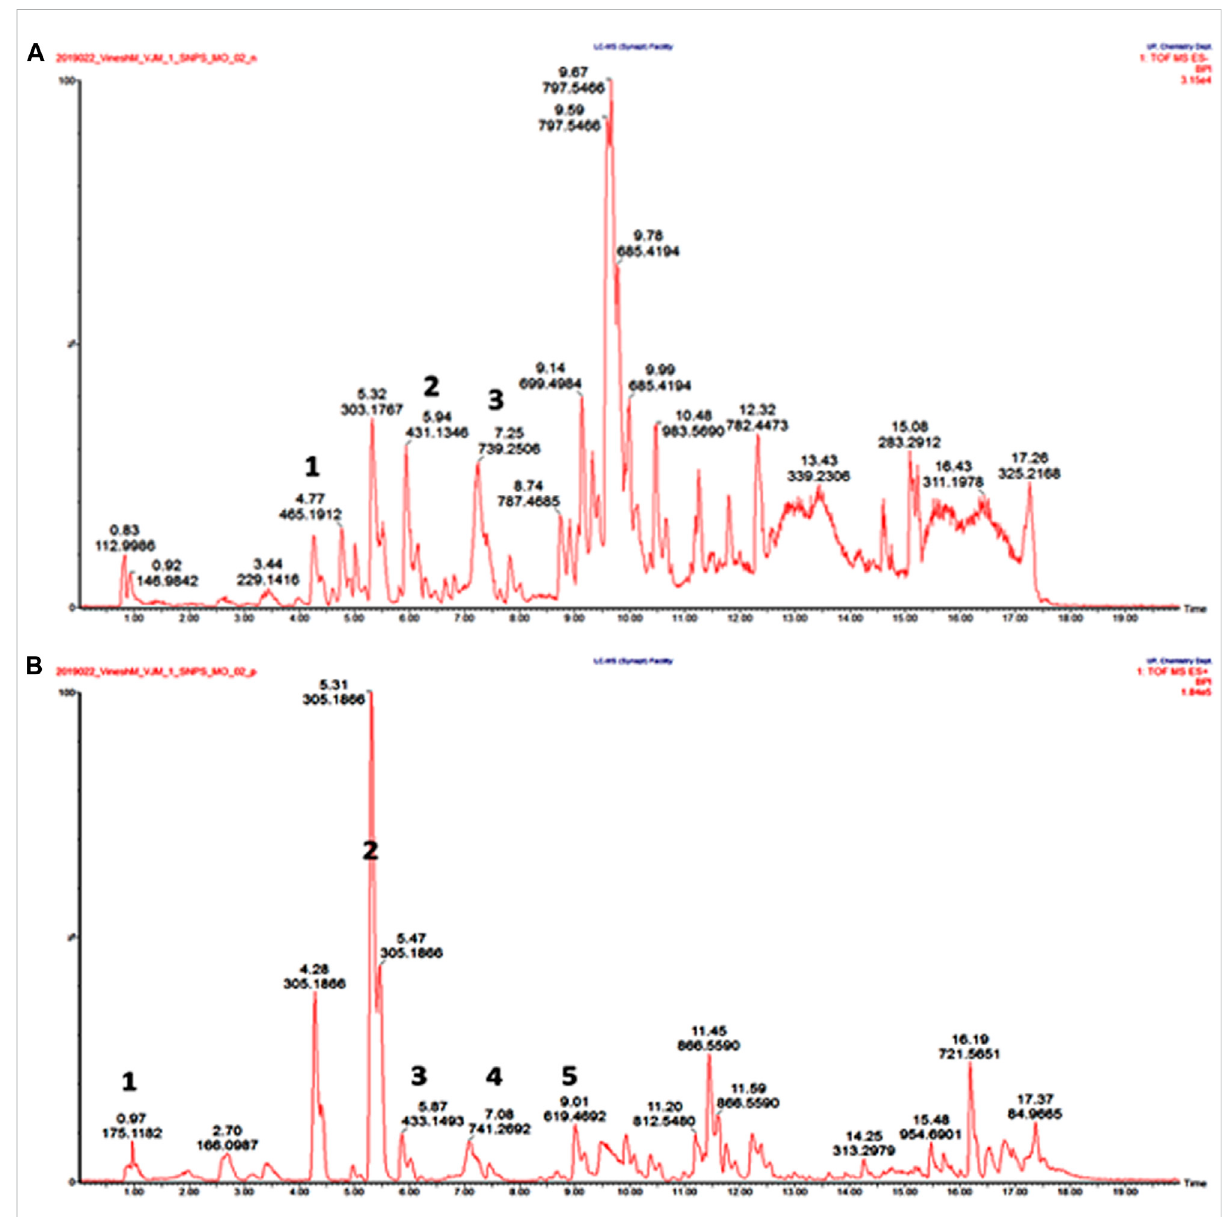
FIGURE 4 UPLC-QTOF-MS/MS total ion chromatogram for M. oppositifolia extract (A) and (B) represent positive and negative ionization modes,